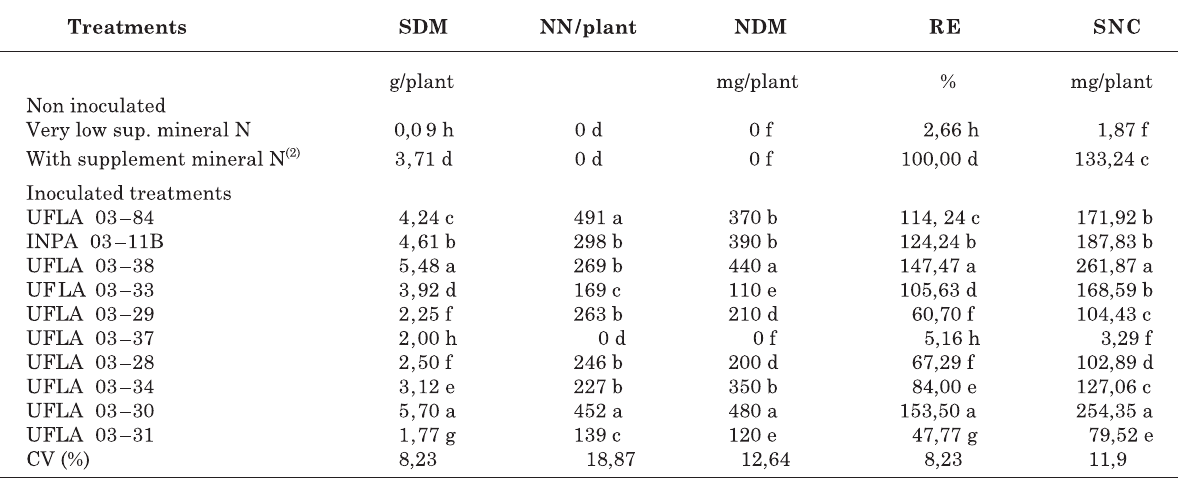
(1) Values followed by the same letter in a column do not significantly differ based on the Scott-Knott test at 5 %; NDM and NN data were adjusted with the square root (x + 1) transformation. (2) Hoagland and Arnon solution (1950) containing 210 mg N - [Ca(NO (14 mg as NH 4+ (NH H PO ) and 196 mg as NO ) .4H O]). This solution was used at ¼ strength for the first 15 days of 4 2 4 3 3 2 2 culture and subsequently at ½